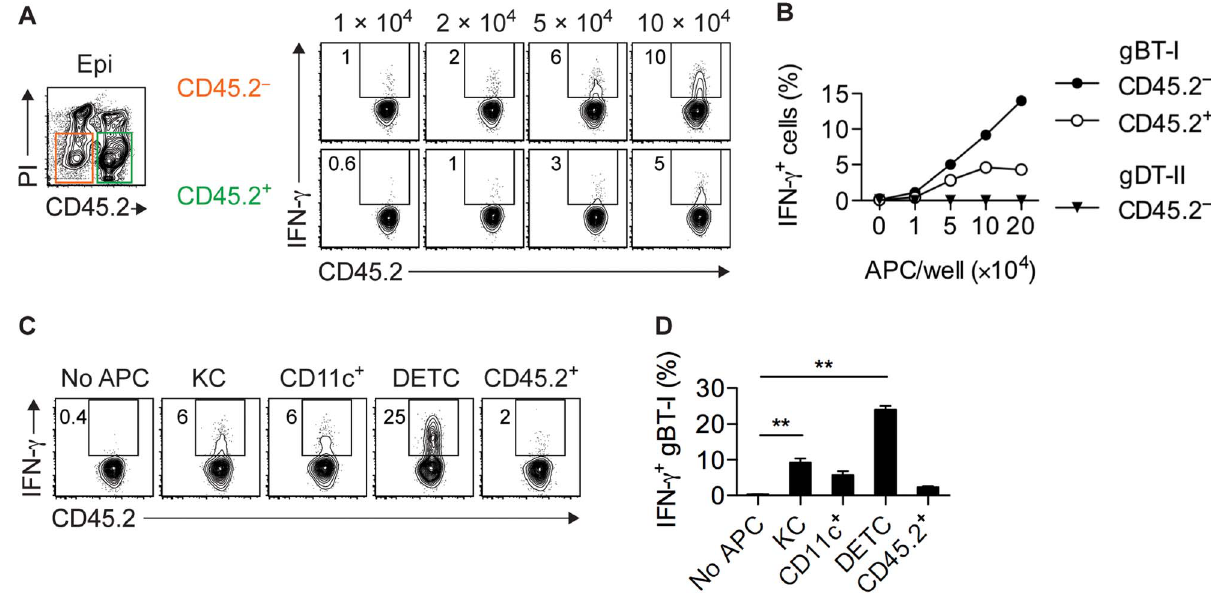
Figure 6. Epidermal APCs trigger IFN- c production by CD8 + T EFF cells. ( A , B ) Analysis of IFN- c + in vitro activated gBT-I ( A , B ) and gDT-II ( B ) T EFF cells cultured (as in Figure 5 ) with increasing numbers of CD45.2 2 and CD45.2 + APCs sorted from epidermal sheets (pooled from 20 mice) 4 days after HSV-1 skin infection. Data representative ( A ) or pooled from 2–3 experiments ( B ). ( C , D ) Analysis of IFN- c + in vitro activated gBT-I cells cultured with sorted APCs from epidermal sheets (pooled from 20 mice) 4 days after infection. APC numbers were 5 6 10 4 for keratinocytes (KC), CD11c + and residual CD45.2 + CD11c 2 V c 3 2 (CD45.2 + ) cells; 3 6 10 4 for DETCs. Data representative ( C ) or pooled from 2 experiments ( D ). **, P , 0.01 by student t- test individually comparing specific APC subsets to control conditions (No